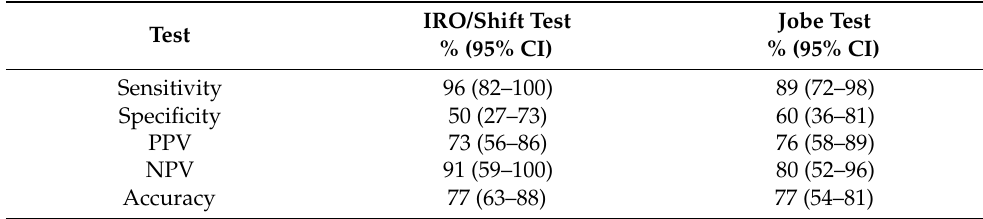
Table 2. IRO/shift and Jobe Tests compared to surgical